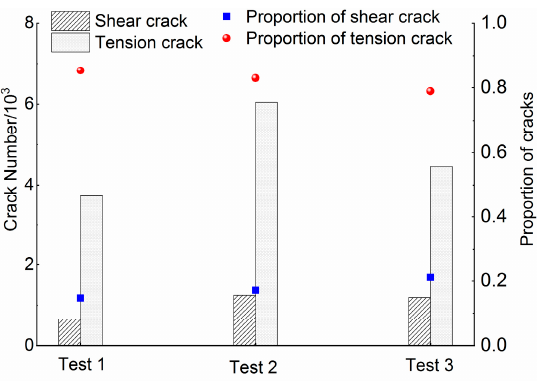
Figure 11. Characteristics of the number of cracks under different paths.